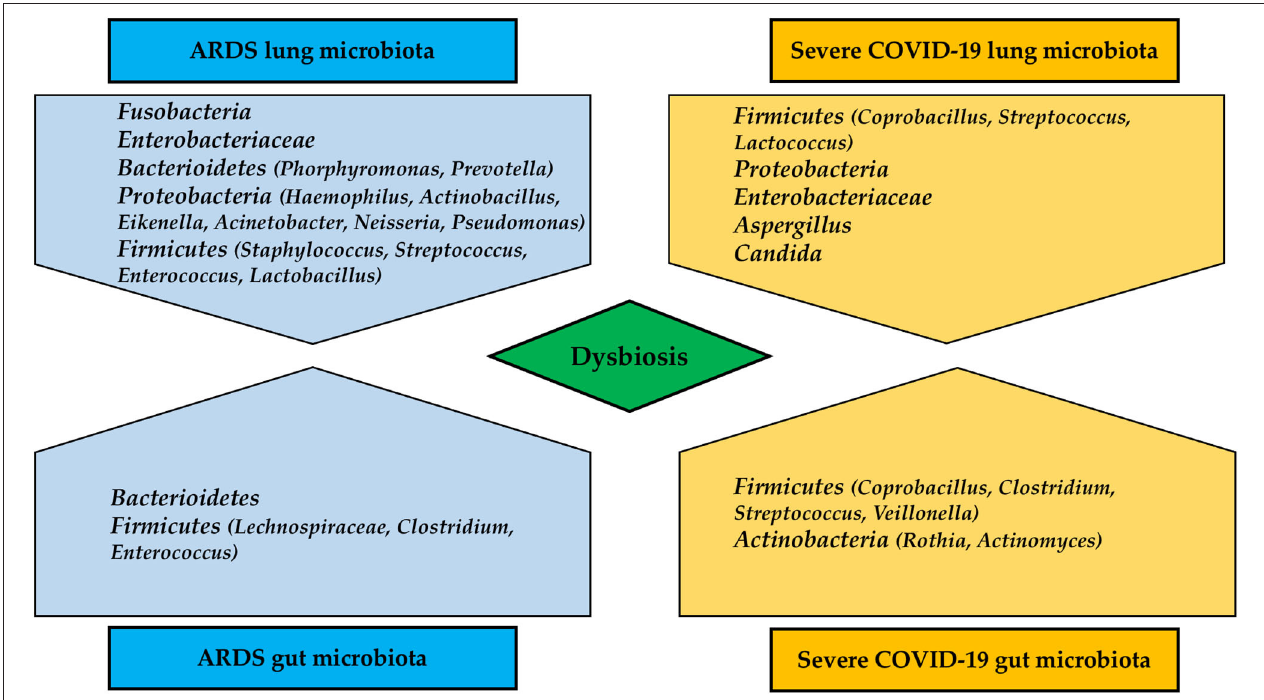
FIGURE 2 | Differences in lung and gut microbiota composition in patients with severe COVID-19 pneumonia and typical